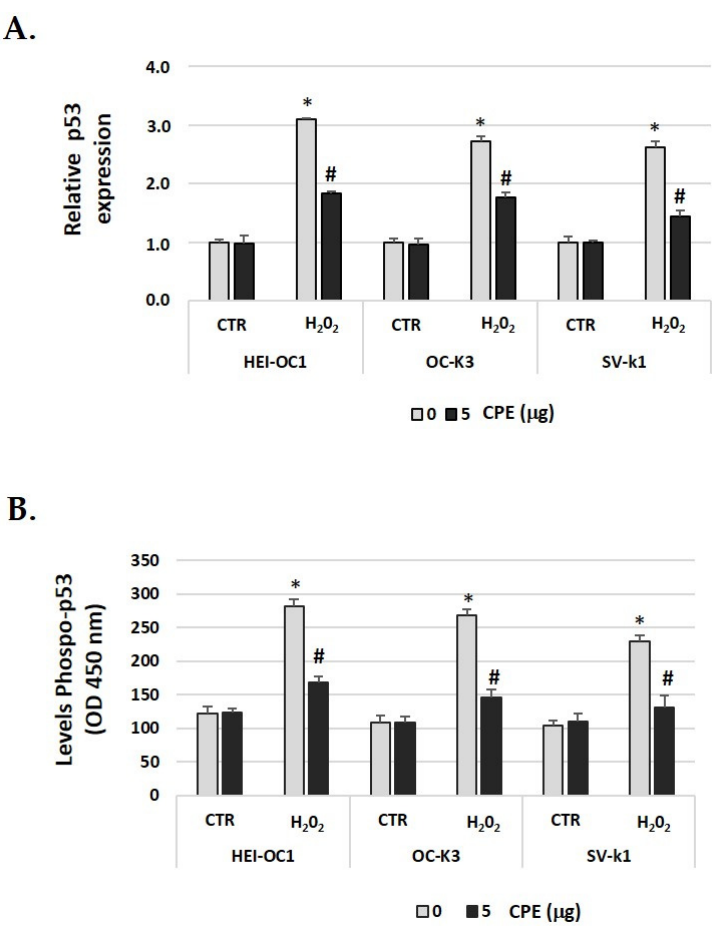
Figure 8. Cocoa reduced the phosphorylation of p53 and gene expression in senescence auditory cells . ( A ) Gene expression of p -53 in auditory cells cultures post-treatments; ( B ) Phospho-p53 levels were determined by ELISA assay in auditory cells lysates post-treatments. Groups: CTR group (0 and 5 µ g/mL of CPE for 20 h) and H 2 O 2 group (CPE-pre-treatment at 0 and 5 µ g/mL for 20 h and H 2 O 2 -post-treatment at 100 µ M for 1 h). The diagrams include the mean ± SD Fold change ( A ) and OD (450) ( B ) (n = 4). * p < 0.05 vs. of CTR group (0 µ g of CPE); # p < 0.05 vs. H 2 O 2 group (0 µ g of CPE) (n = 4). Reference genes: GAPDH and β